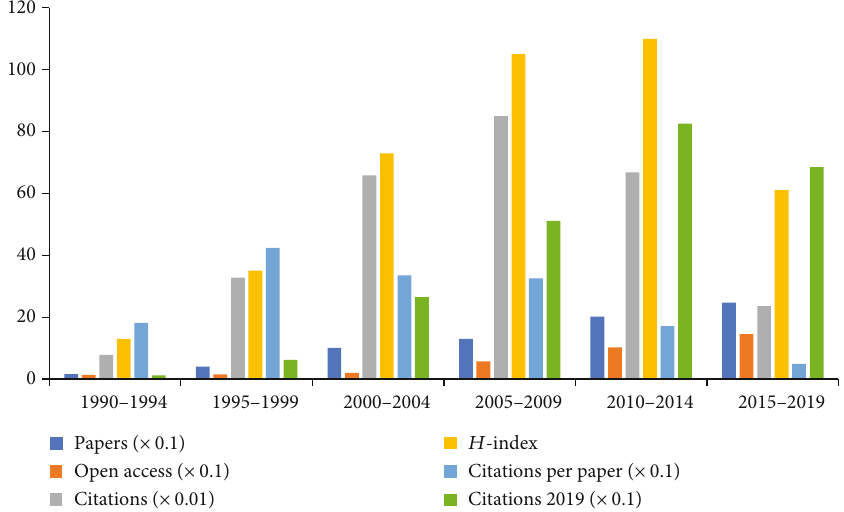
Figure 2: Number of papers, citations, citations per paper, open-access papers, and citations in 2019 and H -index for each 5-year time